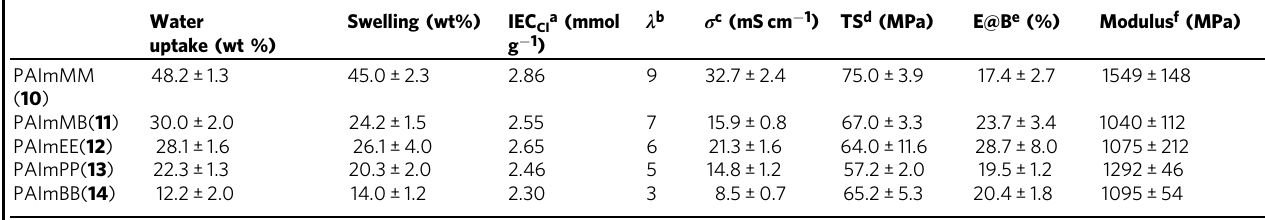
Table 1 Properties of PAImXY(#) membranes Water uptake (wt %)